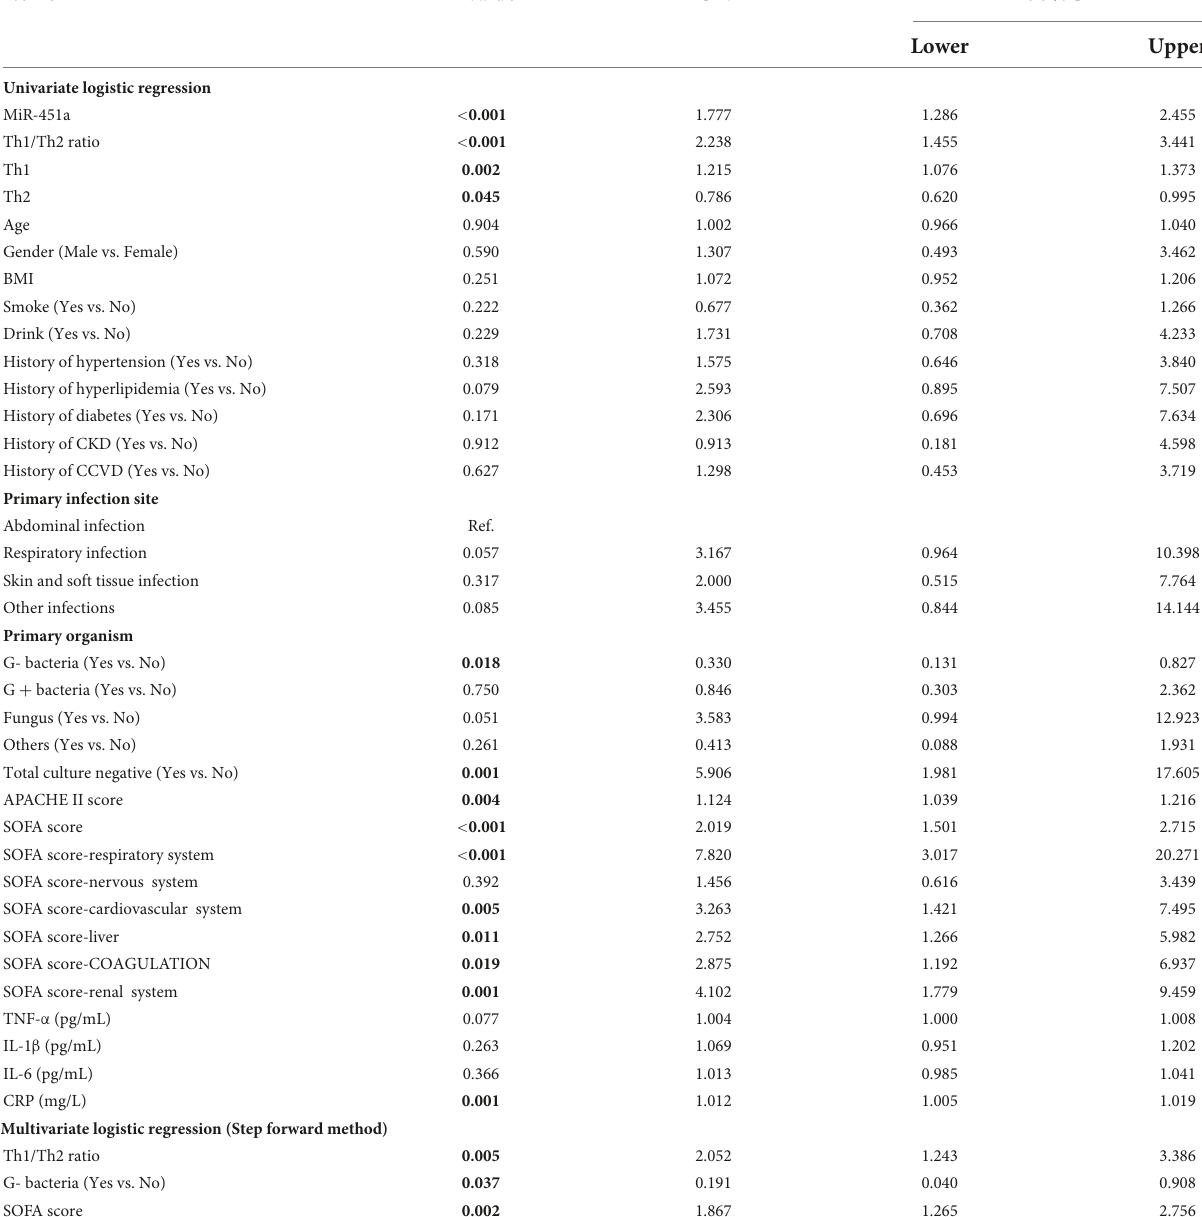
TABLE 3 Factors relating to the 28-day mortality risk in patients with sepsis by logistic regression model analysis. Items P -value OR 95%CI